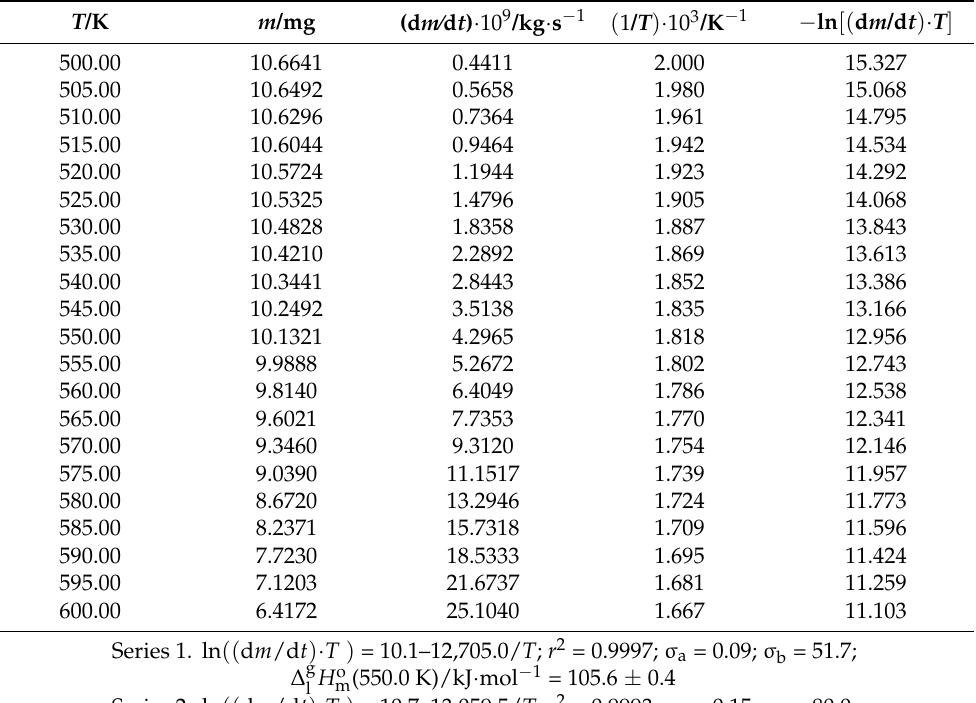
Table 4. Representative experimental data for the determination of the vaporization enthalpy